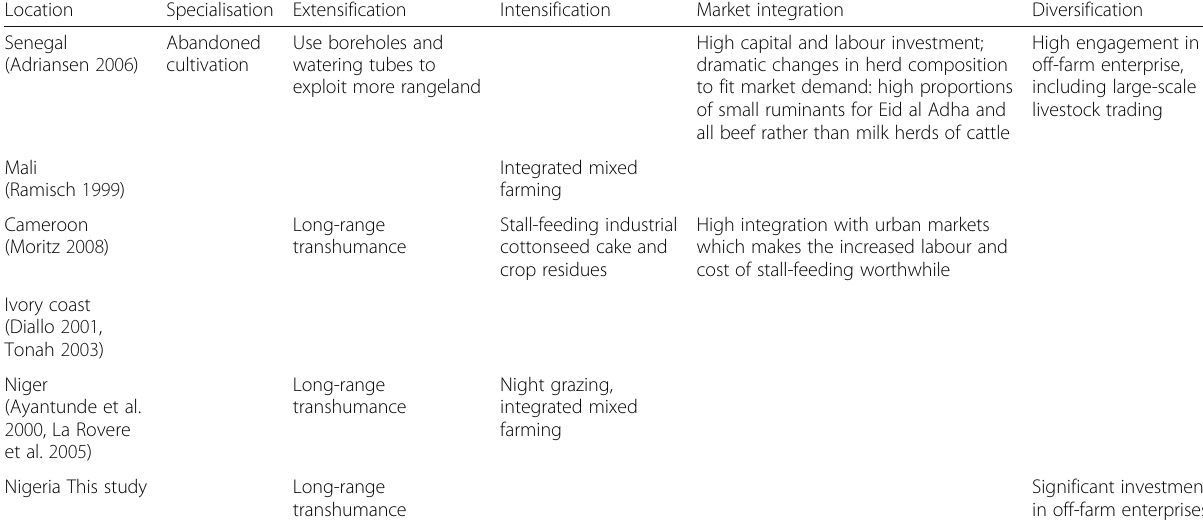
Table 6 Livelihood adaptations of agro-pastoral populations in West